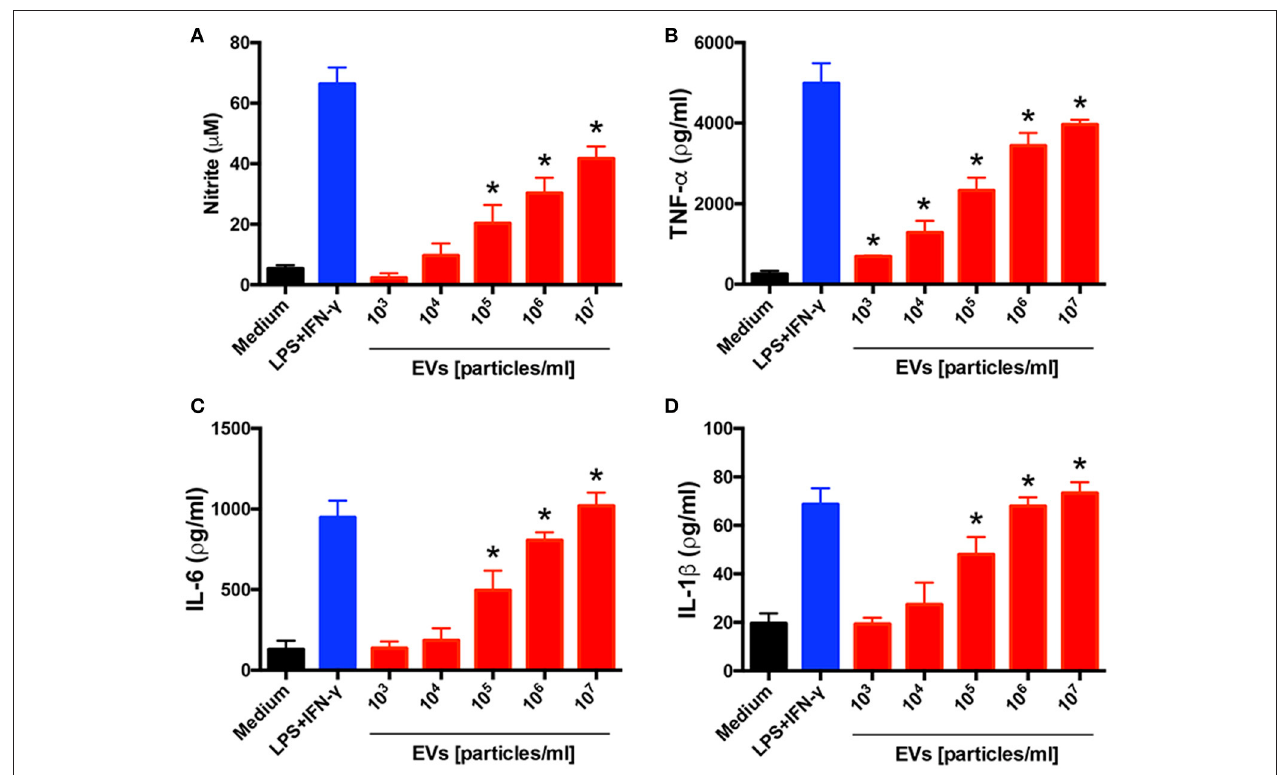
FIGURE 2 | Extracellular vesicles (EVs) from T. interdigitale induce the production of proinflammatory mediators by bone marrow-derived macrophages (BMDMs). BMDMs from C57BL/6 mice were incubated at 37 ◦ C for 48h with the indicated amounts of EVs isolated from T. interdigitale (x-axis). The medium and LPS (1 µ g/mL) plus IFN- γ (2ng/mL) were used as negative and positive controls, respectively. The culture supernatants were assessed for the concentrations of nitrite (A) , TNF- α (B) , IL-6 (C), and IL-1 β (D) . Data are representative of 3 experiments. The results are expressed as means ± SEM and are shown relative to the levels in non-stimulated cells (medium only). * P <